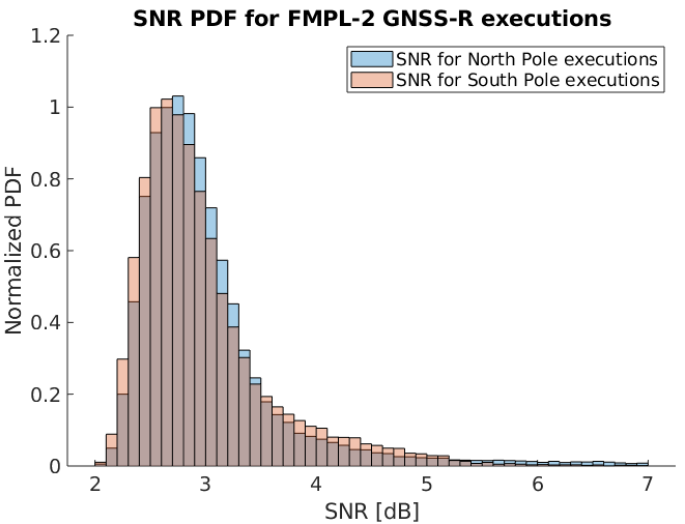
Figure 12. SNR histogram for both North and South poles for all GNSS-R tracks collected from